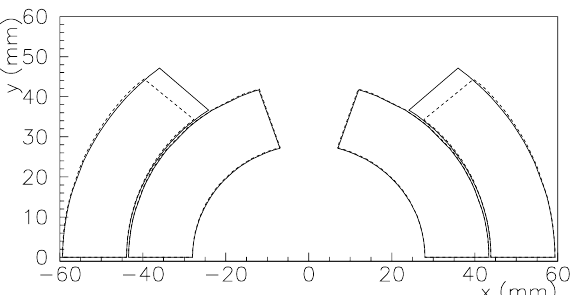
FIG. 6. Nominal coil geometry (solid line) and deformed ge- ometry (dashed line) induced by a 0.1 mm thicker shim in the outer coil. Deformations are magnified by a factor of 50.